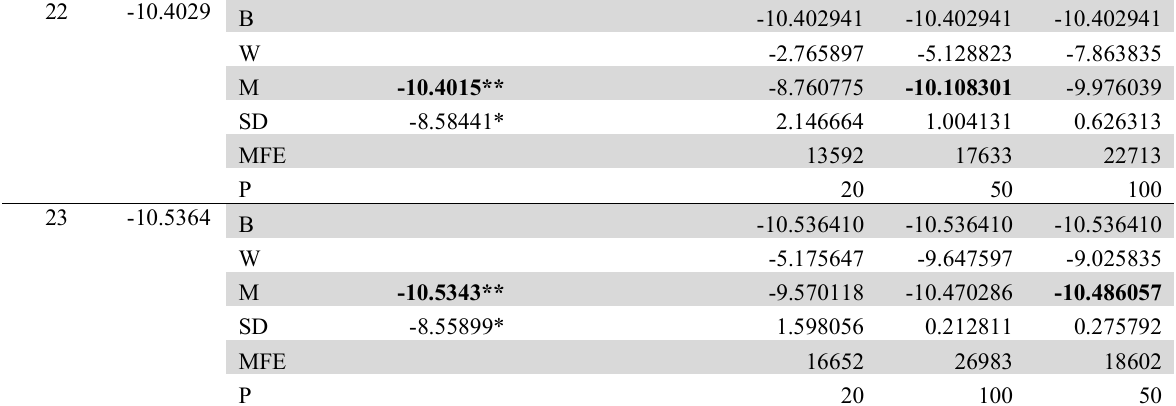
Results of the proposed algorithms for 23 benchmark functions considered (30000 function evaluations)